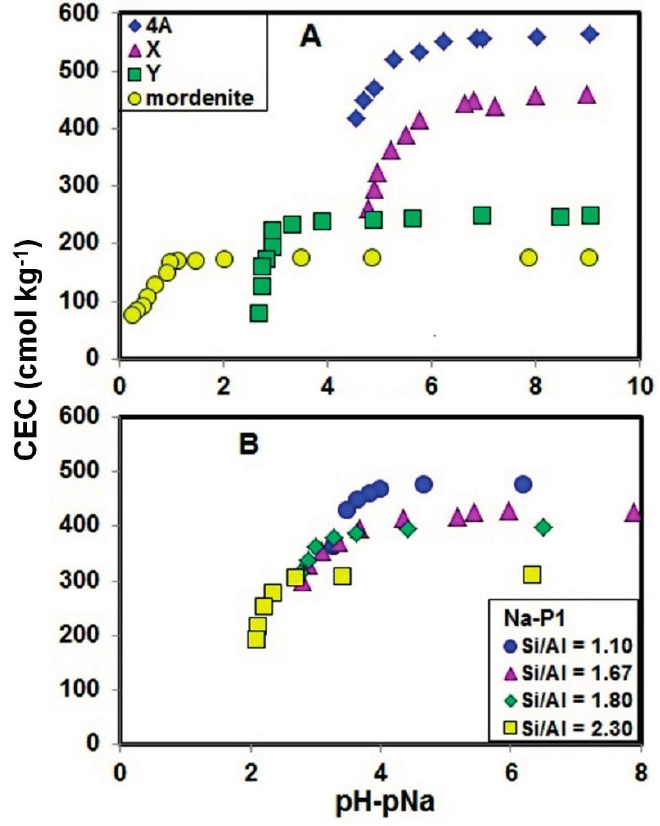
Figure 3. Change in CEC of zeolites with change in pH − pNa. ( A ) Plots of 4A, X, Y and mordenite type zeolites. ( B ) Plots of Na-P1 with different Si/Al ratio. The unit of CEC, cmol·kg − 1 , means centimole per